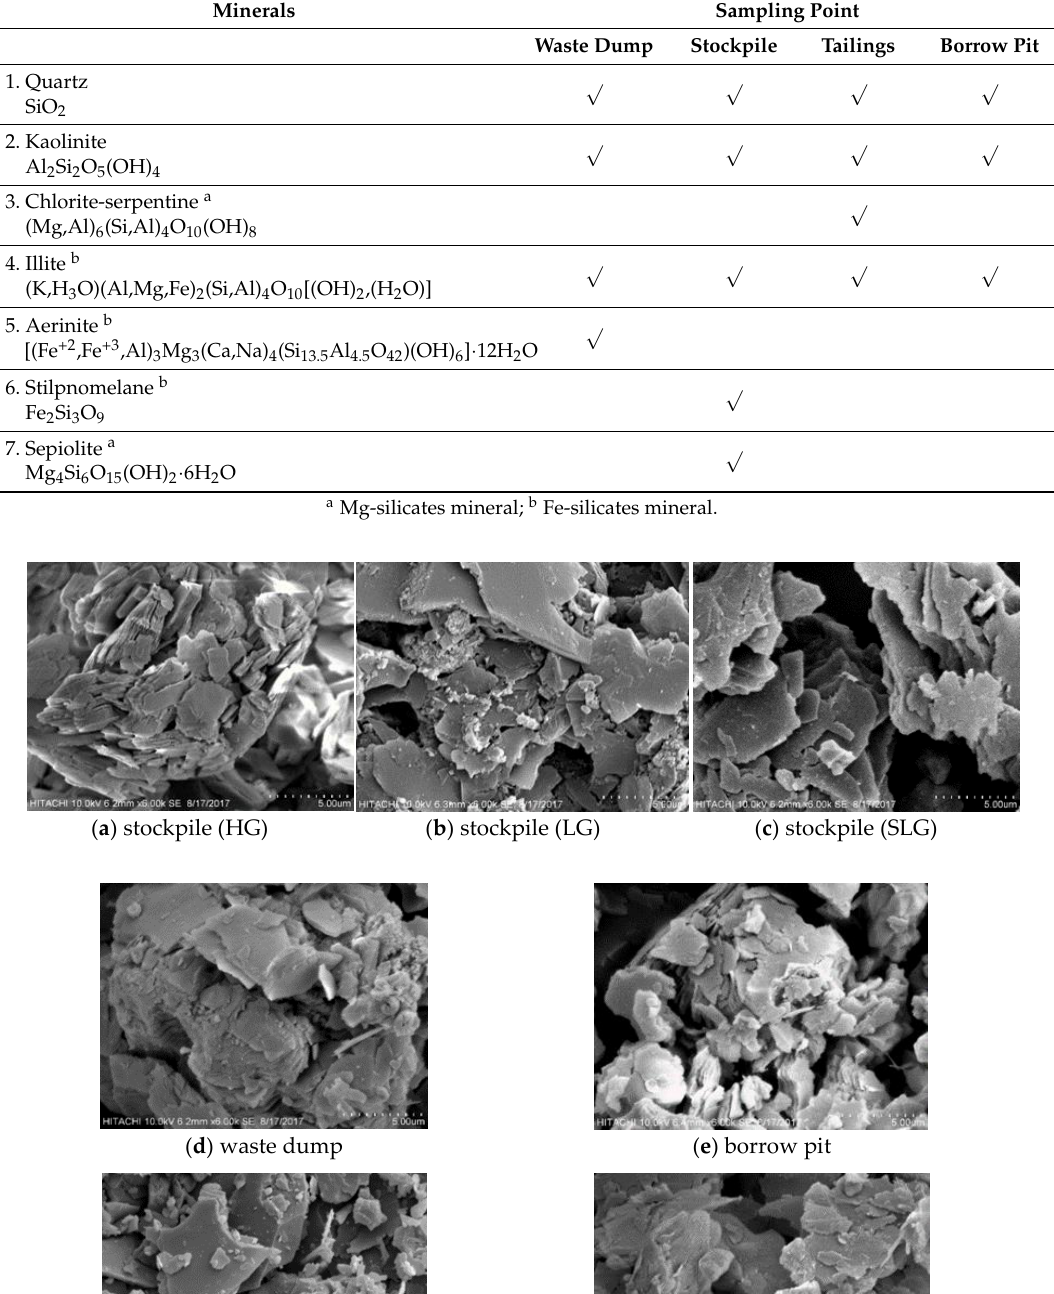
Table 3. Summary of mineral composition of clay fraction in soil, sludge and sediment samples of the waste dump, stockpile, mine tailings, and borrow pit. Symbol of (√) is referring to the presence of minerals in sampling points.